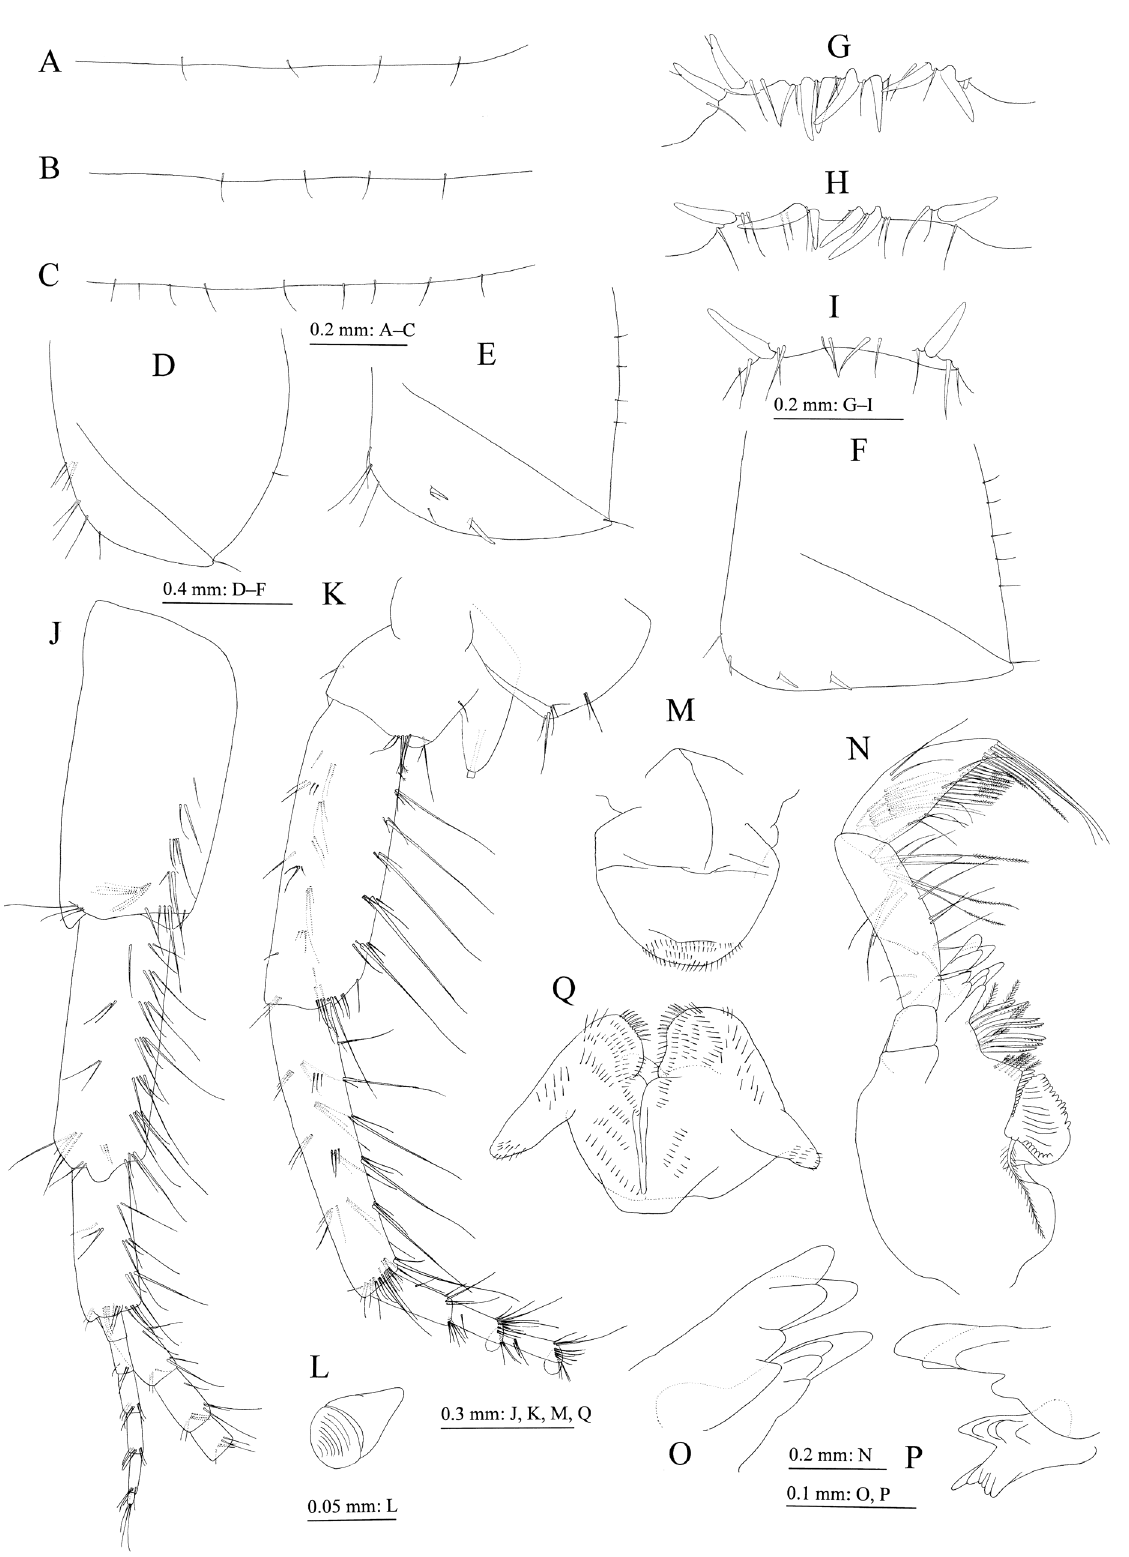
Figure 3. Jesogammarus bousfieldi sp. n., holotype, male (9.8 mm), NSMT-Cr 25470. A–C dorsal margins of pleonites 1–3, respec- tively, dorsal views; D–F epimeral plates 1–3, respectively, lateral views; G–I dorsal margins of urosomites 1–3, respectively, dorsal views; J peduncular articles 1–3, accessory flagellum, and flagellar articles 1–3 of antenna 1, medial view; K peduncular articles 1–5 and flagellar articles 1–3 of antenna 2, medial view; L calceolus of antenna 2, medial view; M upper lip, anterior view; N left mandible, medial view; O incisor and lacinia mobilis of left mandible, lateral view; P incisor and lacinia mobilis of right mandible, lateral view; Q lower lip, ventral